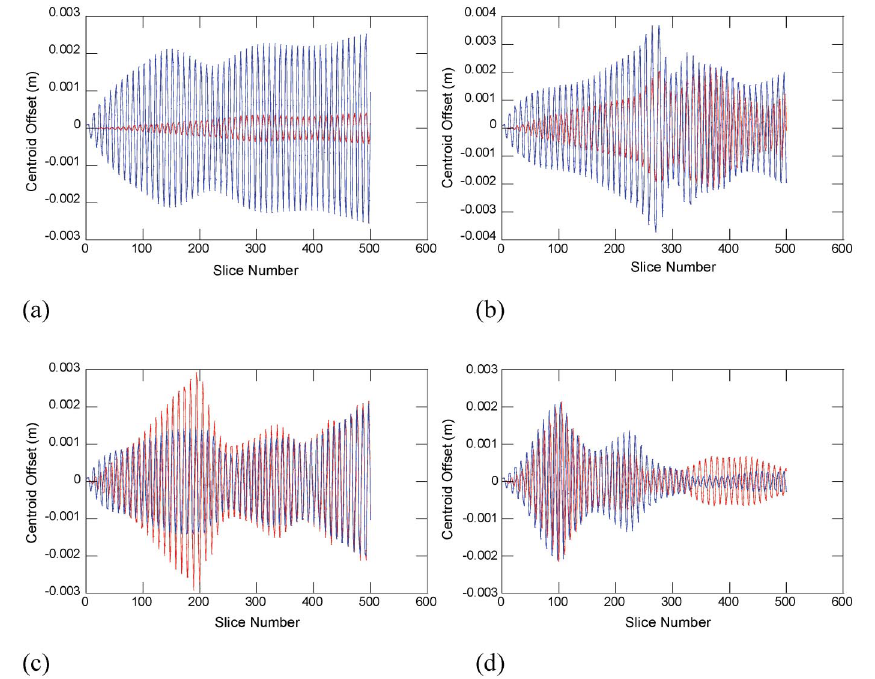
FIG. 15. (Color) Ion centroid evolution for 20-MeV, 3-mm, resonant beam case at different axial positions. Each slice is 0.4 nsec long. The red line is for the horizontal offset and the blue line is for the vertical offset. (a) z (cid:4) 0 : 625 m , (b) z (cid:4) 1 : 25 m , and (c) z (cid:4) 2 : 5 m , and (d) z (cid:4) 5 m .